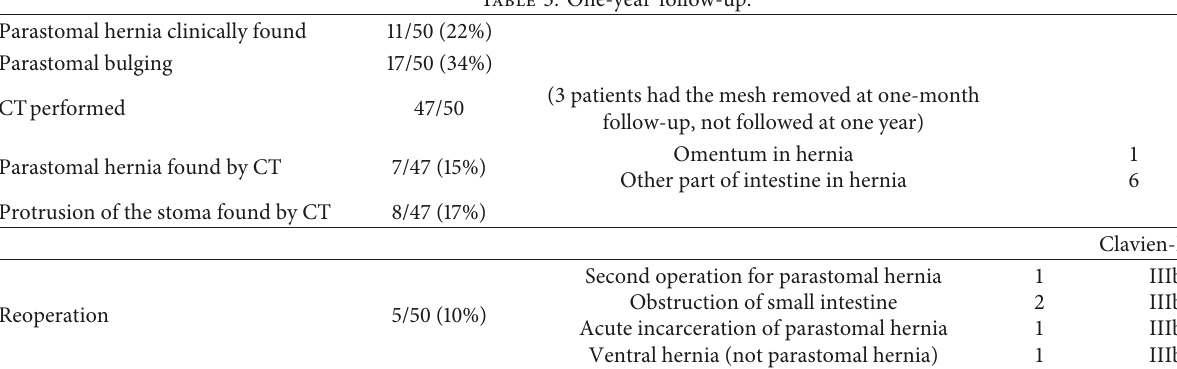
Table 3: One-year follow-up.